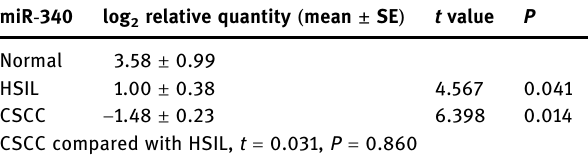
Table 3: miR - 340 in cervical squamous cell carcinoma, high - grade intraepithelial lesions, and normal squamous epithelium miR - 340